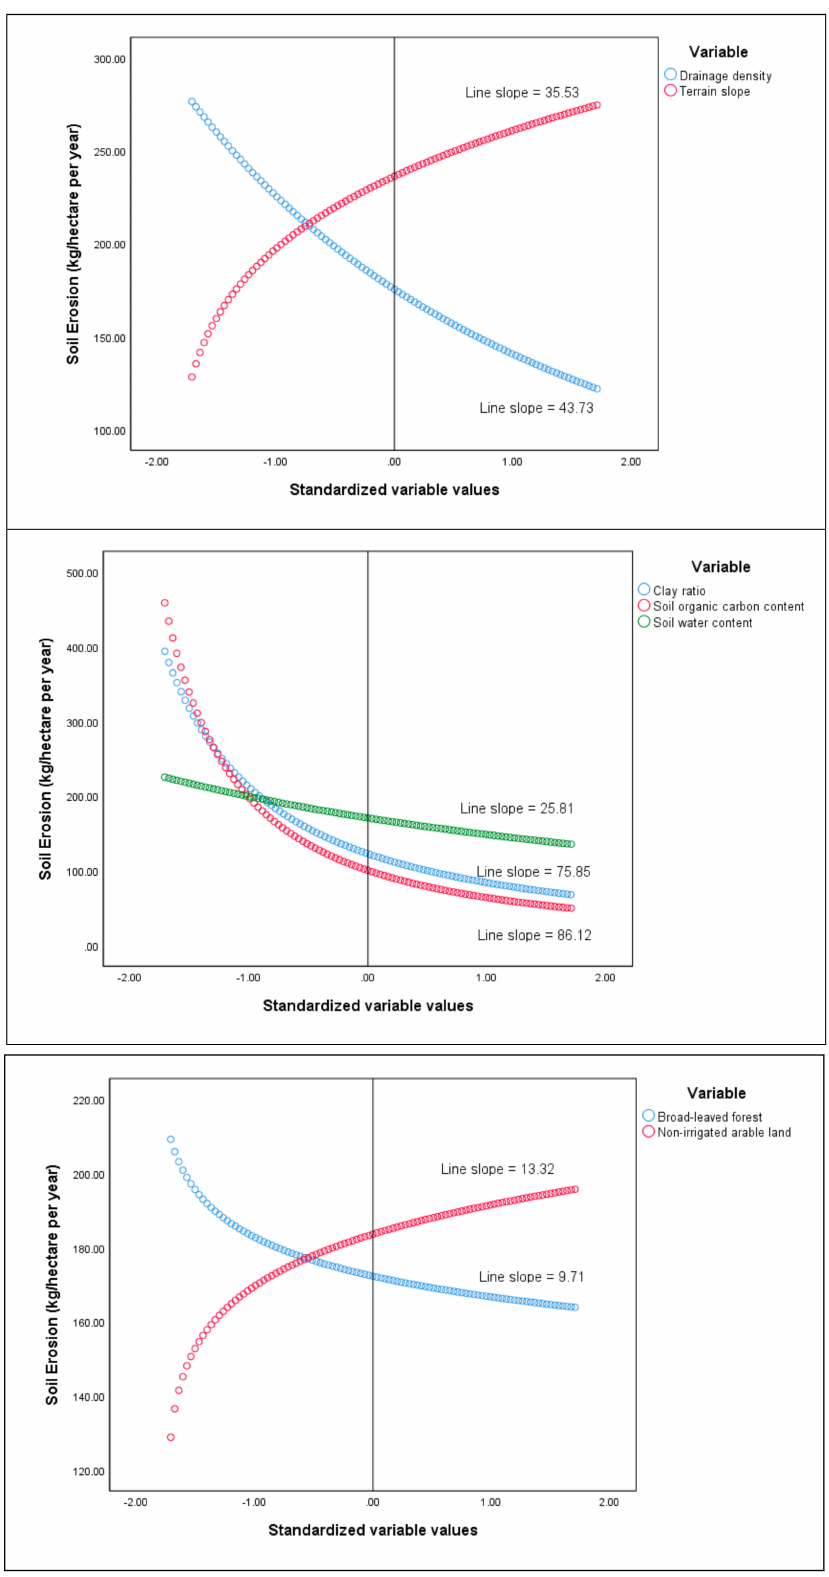
Figure 3. Results of the sensitivity